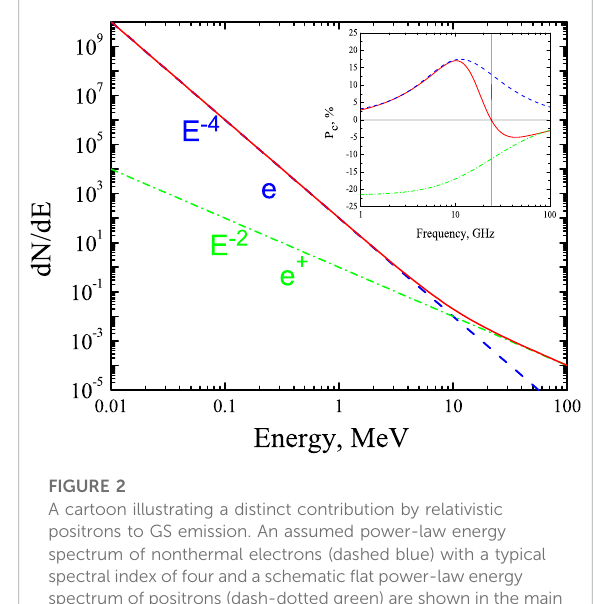
FIGURE 2 A cartoon illustrating a distinct contribution by relativistic positrons to GS emission. An assumed power-law energy spectrum of nonthermal electrons (dashed blue) with a typical spectral index of four and a schematic fl at power-law energy spectrum of positrons (dash-dotted green) are shown in the main panel. Note that real spectra of relativistic positrons may deviate fromthepower-law,butcontainabumpinthe1 – 10 MeVrange.In this example, the total number of electrons is almost six orders of magnitude larger than the number of positrons. The red solid curve shows the composite spectrum dominated by electrons at low energies and by positrons at high energies. Circular polarization of the GS emission produced by these two components, appropriately color-coded, and by their composition is shown in the inset. The positron contribution results in the polarization reversal at a high frequency shown by red arrow. The demarcation frequency depends on the magnetic fi eld at the radio source and the crossing point in the energy spectra and can vary between dozens and hundreds